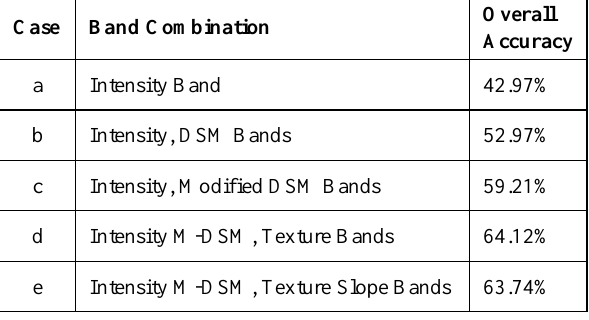
Table 1: Accuracy Assessment of Pixel-Based Classification